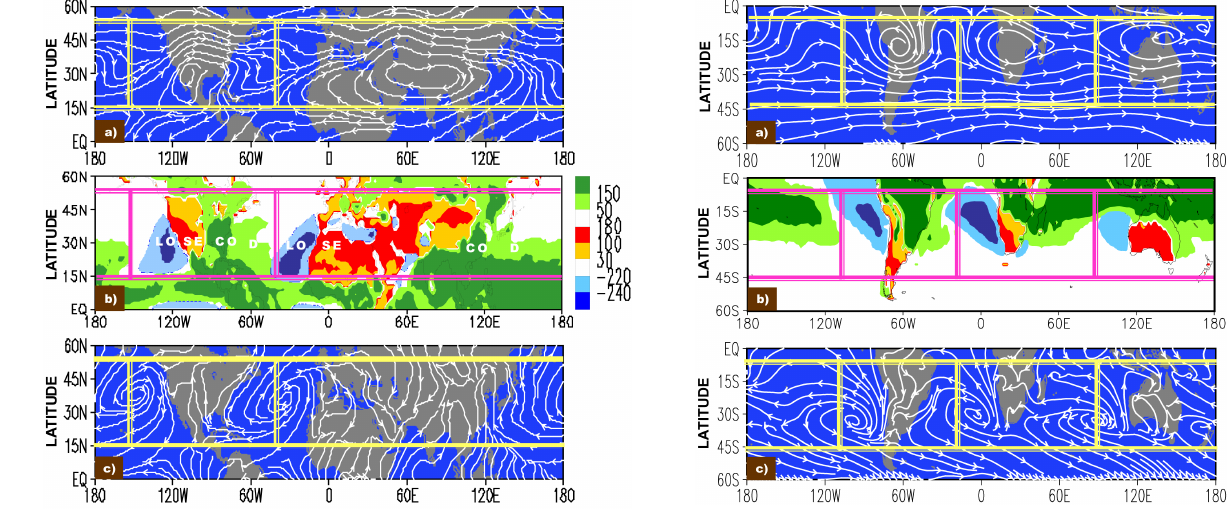
Fig. 6. Distributions of July mean quadruplet LOSECOD dominant heating ( b , unit is Wm − 2 ; adopted from Fig. 3b of Wu and Liu, 2003), and circulation at 200hPa (a) and 1000hPa (c) . Each grid along the subtropics has one continent in the center and is bounded by the longitudes at which the centers of sea-surface anticyclones are located. The abbreviations LO, SE, CO, and D in panel (b) indicate the geographic locations at which the vertical profiles of heating are plotted in Fig. 5.